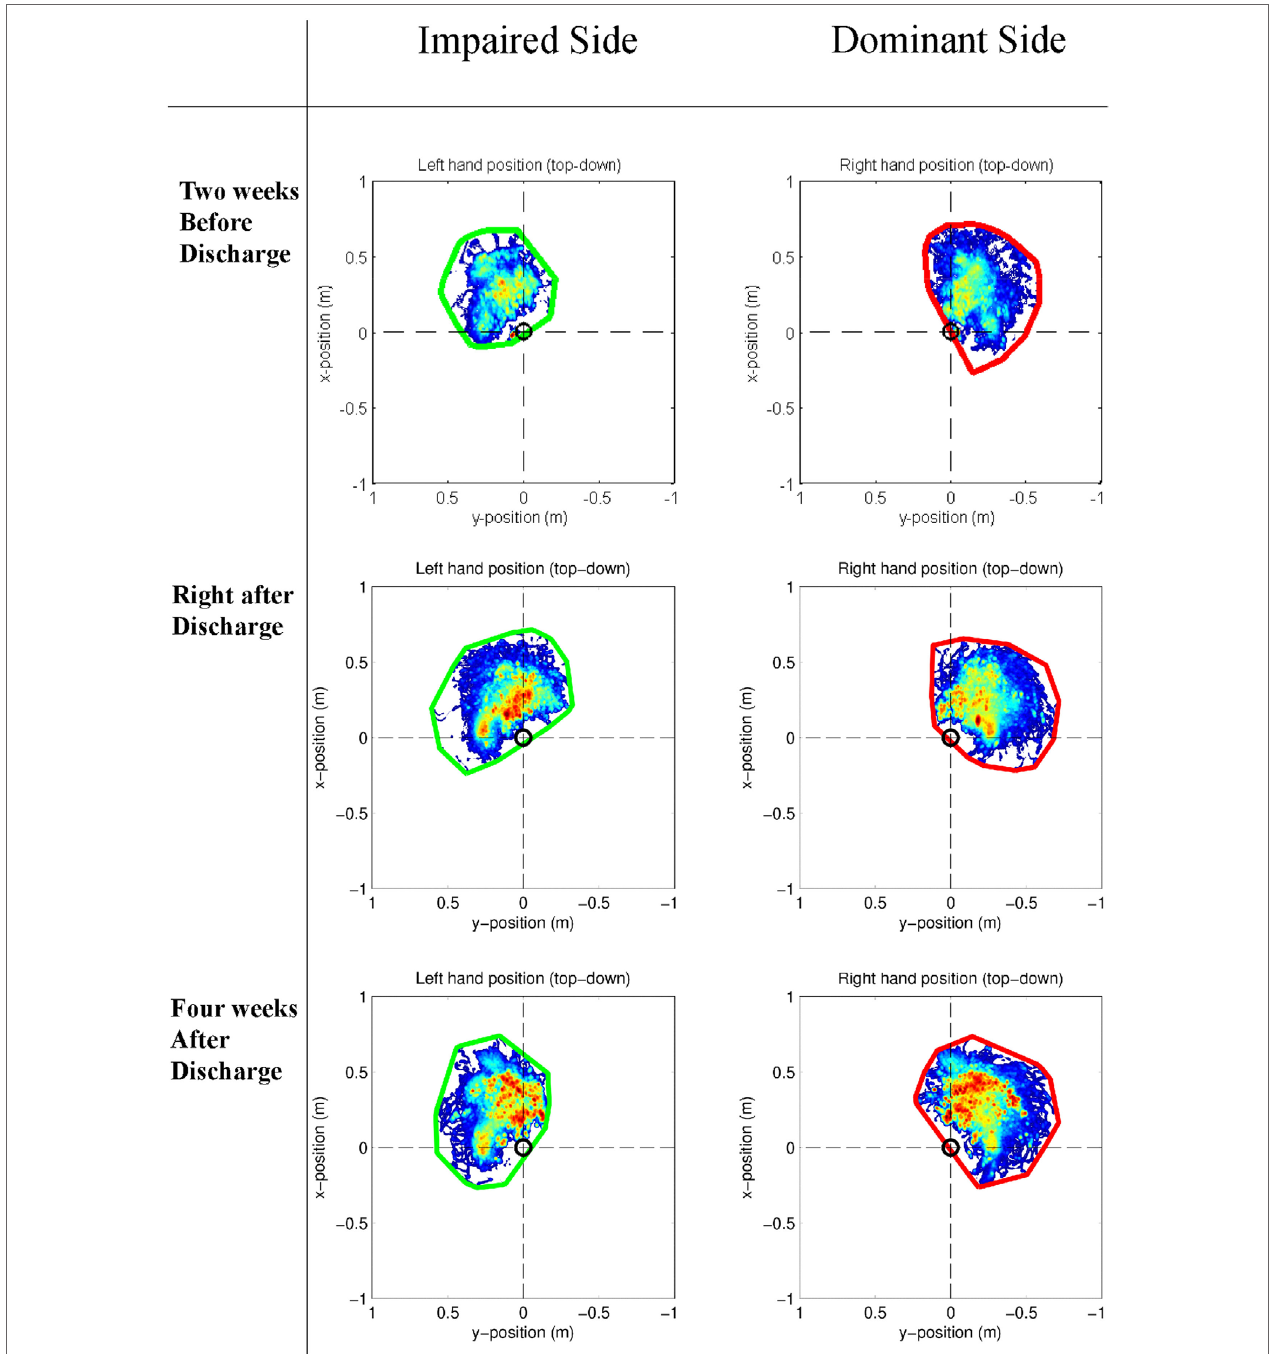
FigUre 4 | Example of the distribution of the hand position relative to the pelvis in the horizontal plane (colors indicate the total time during the selected time slot at which the hand is in a certain position, where a darker color reflects a longer time) of P2 at the three different stages in the rehabilitation process during self-directed activities of daily living. The encircled trajectory (left hand = green, right hand = red) determines the reaching area of the